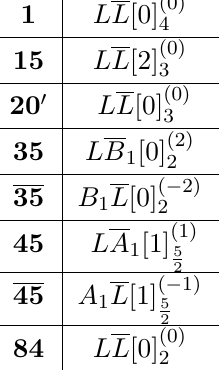
Table 12 . The N = 2 multiplets from level n = 4 .